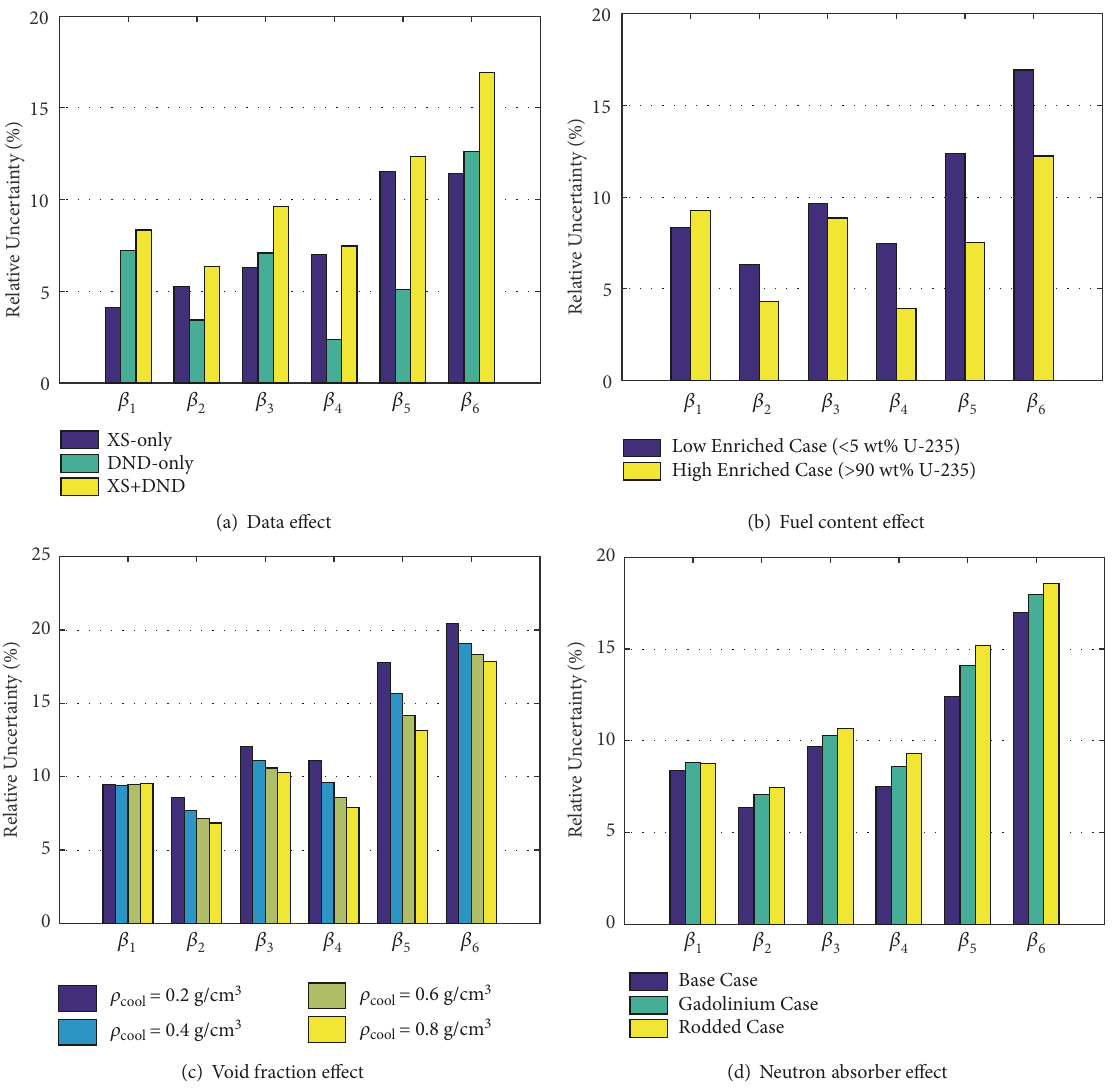
Figure 4: Precursor-group-wise DNF ( 𝛽 𝑖 ) relative uncertainty (in %) for various sensitivity cases at BOL: (a) data source (PWR pin-cell), (b) initial fuel content (PWR pin-cell), (c) void fraction (BWR lattice), and (d) neutron absorber (PWR lattice).